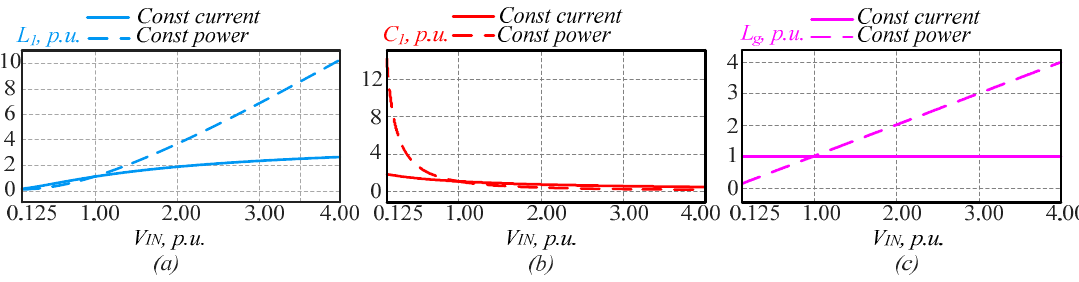
Figure 5. Influences of the buck-boost on the passive elements at constant input power and current: the main inductance ( a ), the output capacitance ( b ), the output inductor filter ( c ). The ripple factor is constant for each element. All the values of inductances or the capacitor